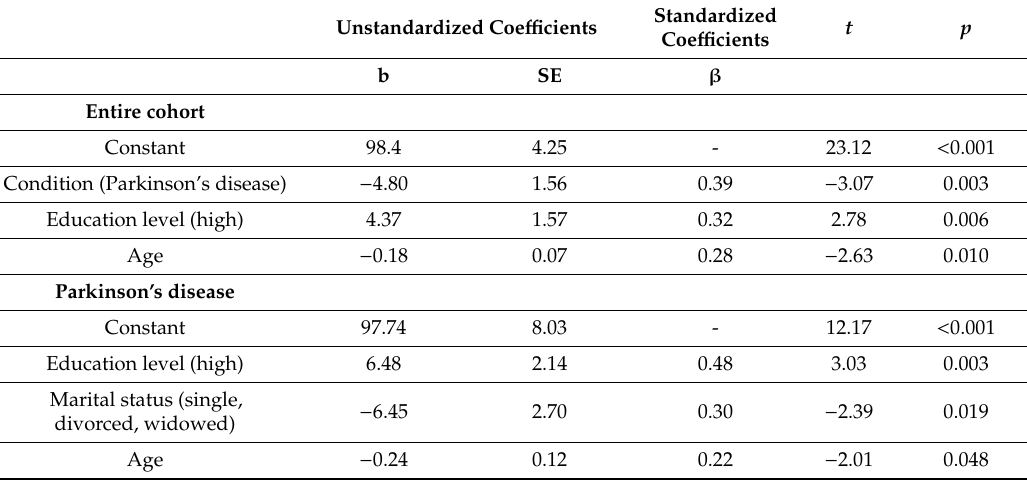
Table 3. Linear regression analysis: Predictors of mean desired quality of